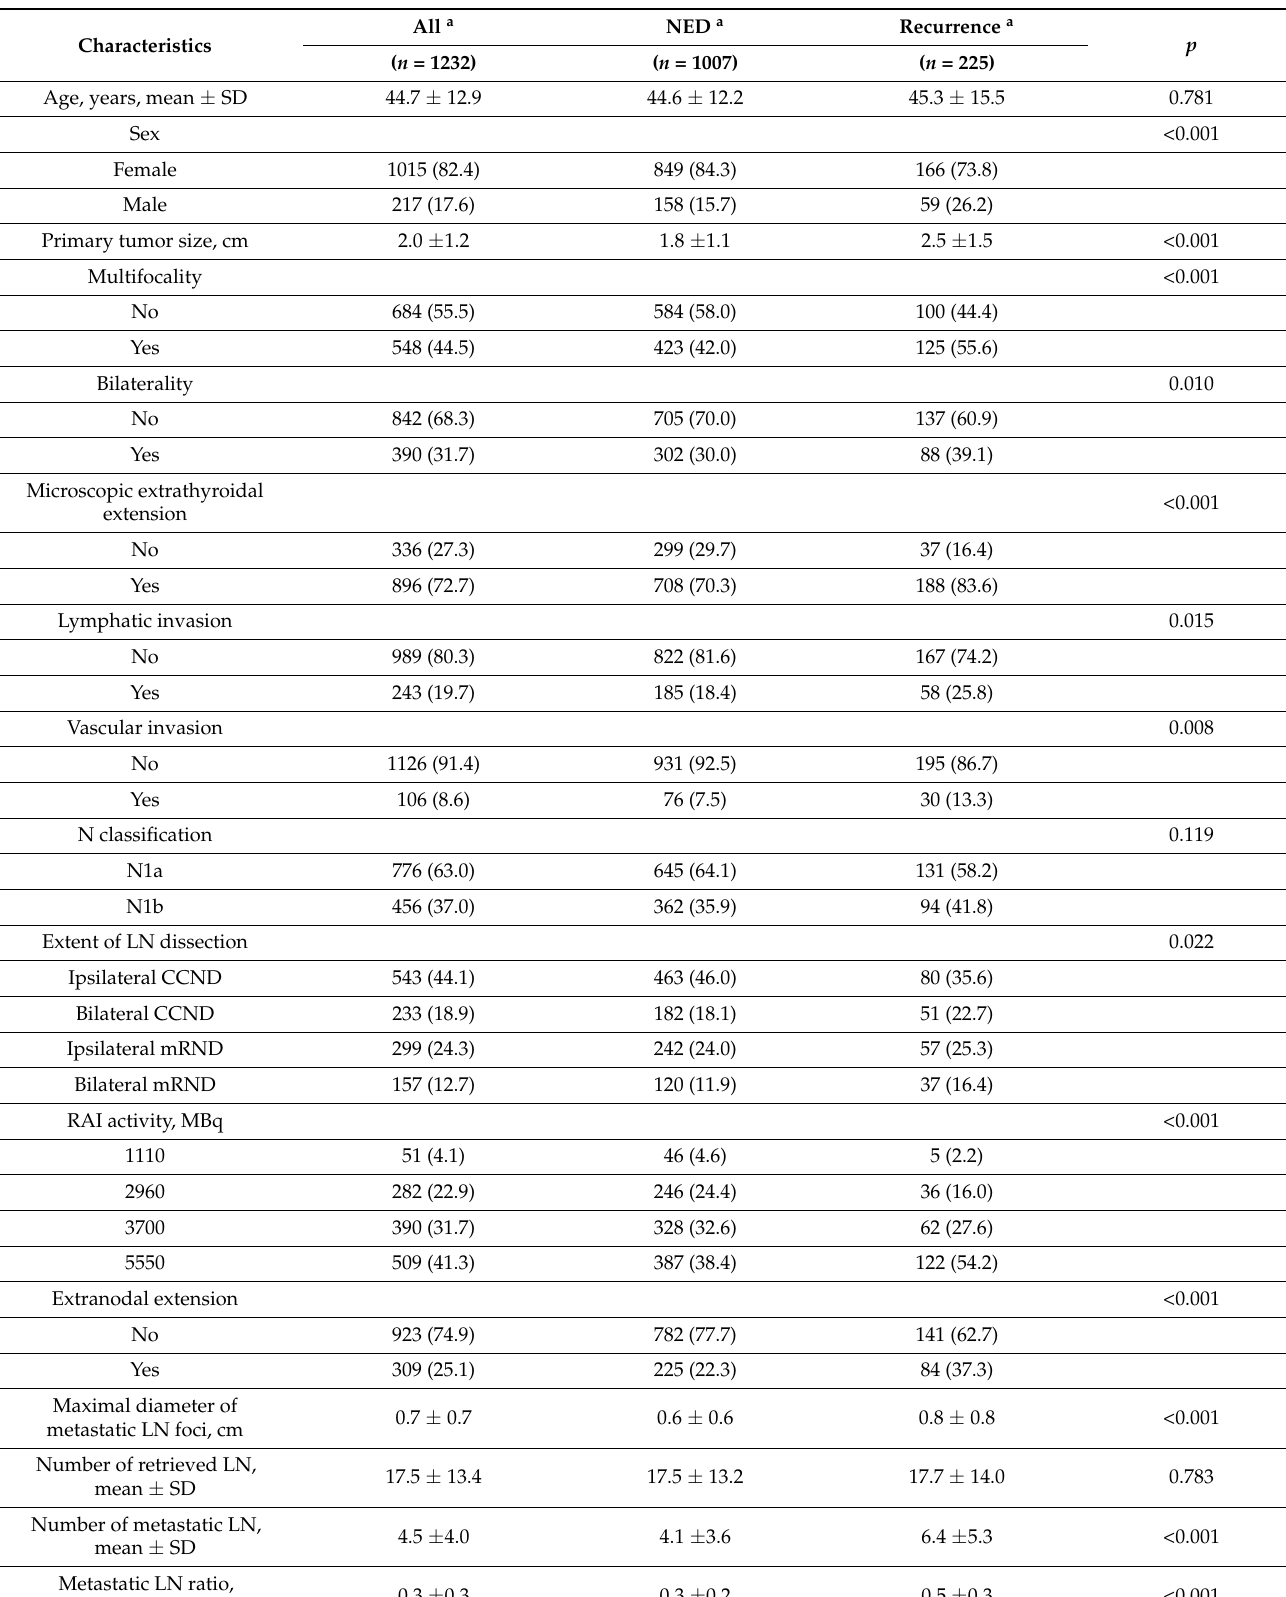
Table 1. Patient demographic